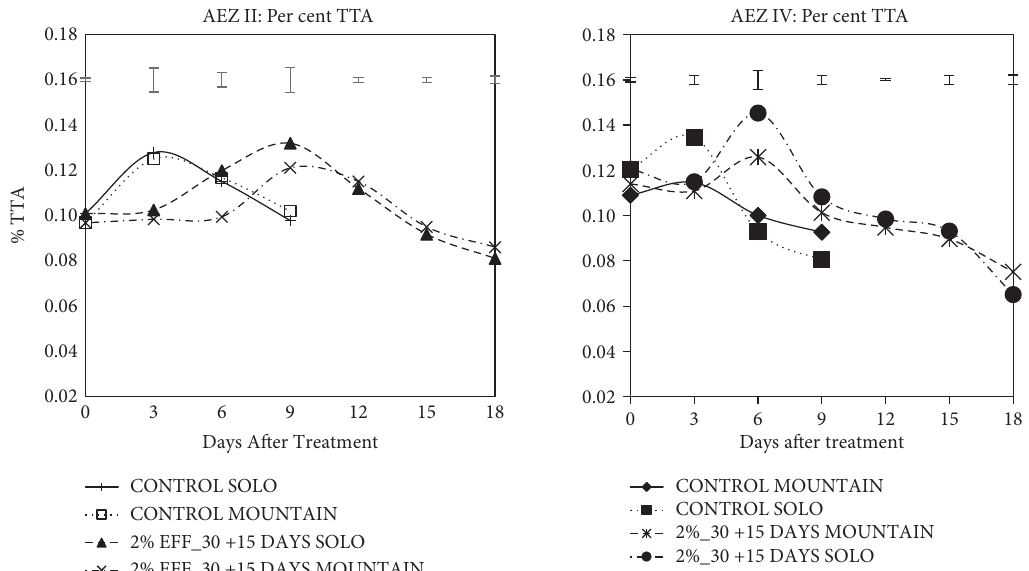
Figure 8: Percent TTA present in papaya fruits treated with Hexanal spray from Machakos and Meru counties. Top bars represent LSD at